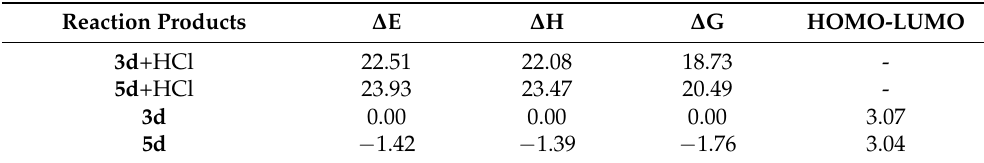
Table 1. Relative energies ( Δ E, kcal/mol), enthalpies ( Δ H, kcal/mol), Gibbs energies ( Δ G, kcal/mol) and HOMO ‐ LUMO gaps (eV) of the products 3d and 5d with HCl compared to the initial reagents